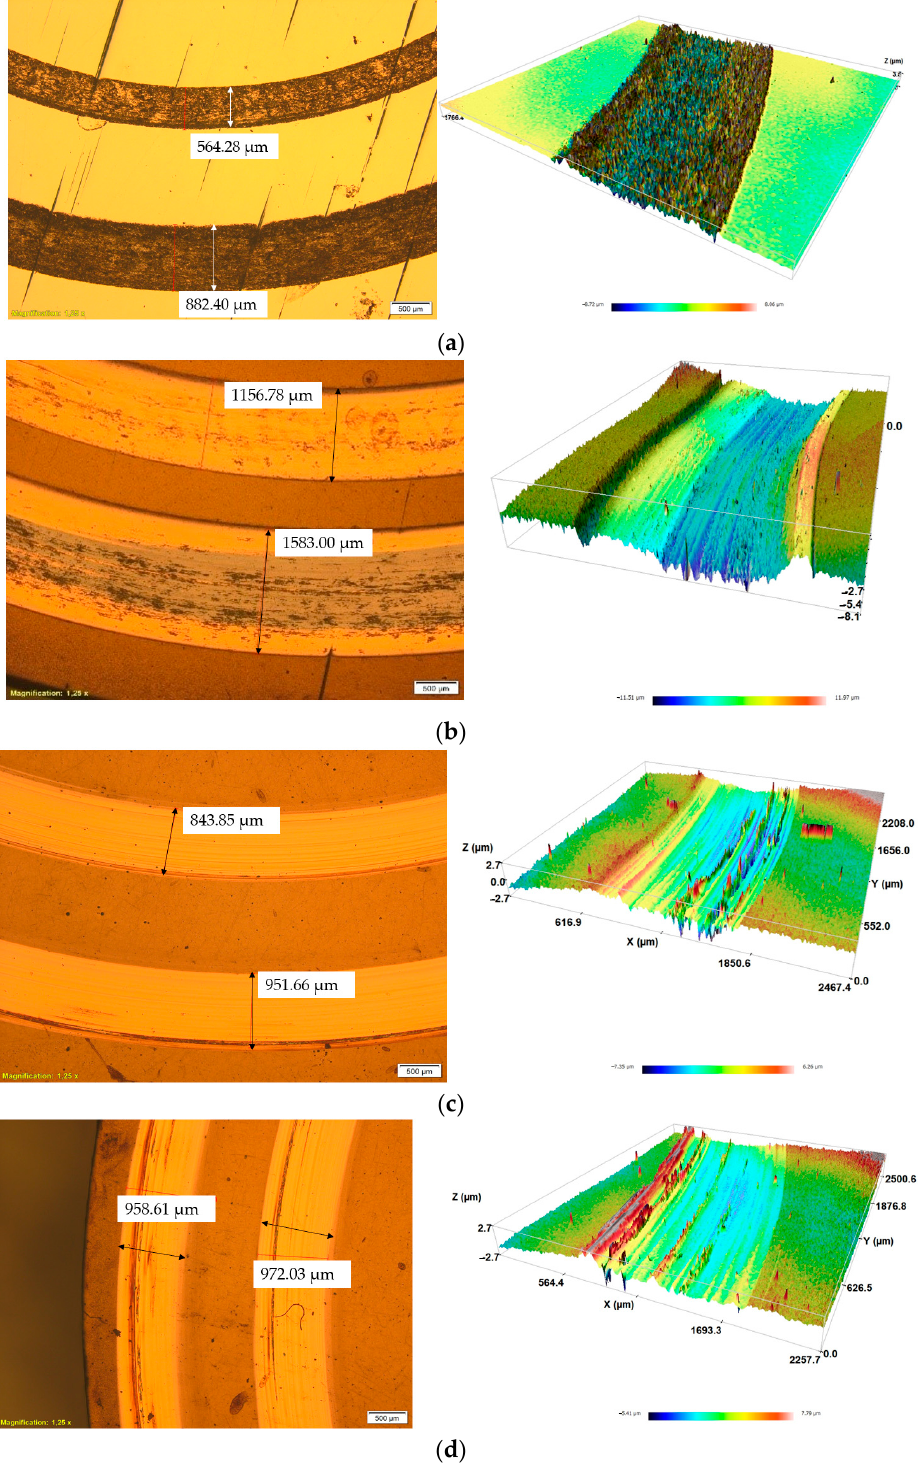
Figure 9. Example of the wear tracks obtained by optical microscopy (left) and confocal microscopy (right) for the uncoated 1.2379 sample ( a ), 1.2379 + PVD sample ( b ), 1.2379 + Duplex sample ( c ), and Vanadis 4 + Duplex sample ( d ).